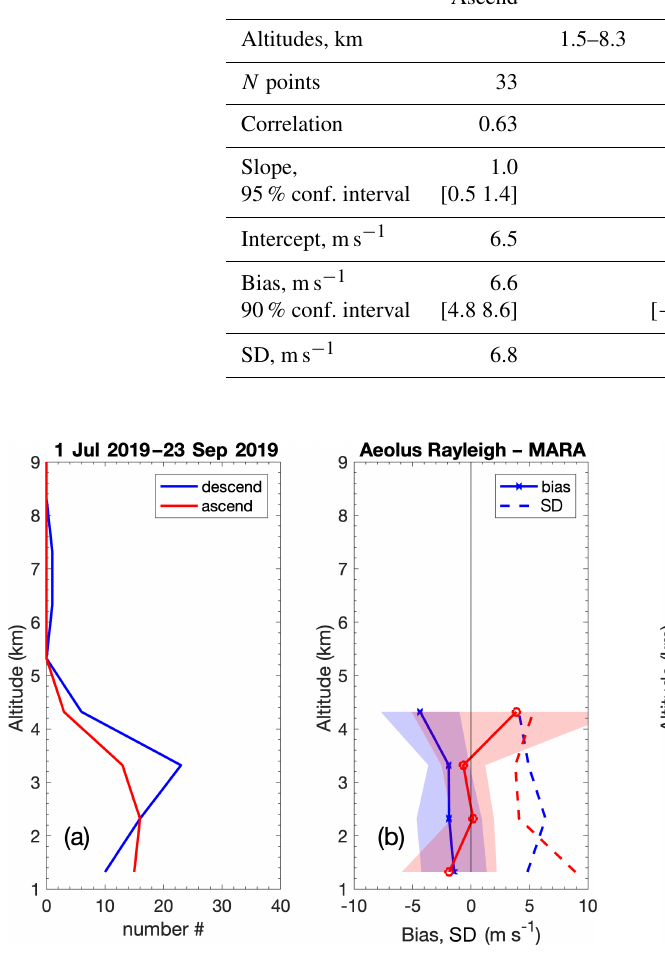
Figure 5. The same as Fig. 4. but for Aeolus Rayleigh HLOS winds and MARA-derived HLOS winds for the Antarctic summer